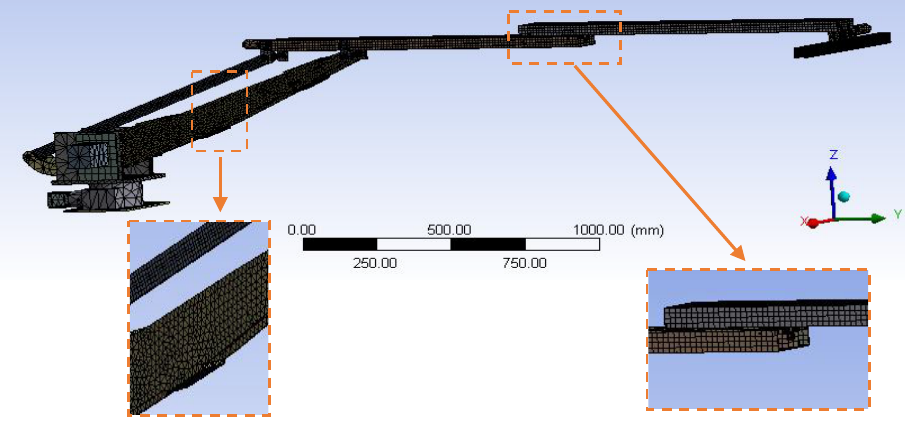
Figure 4. Fully-extended Configuration meshed structure.